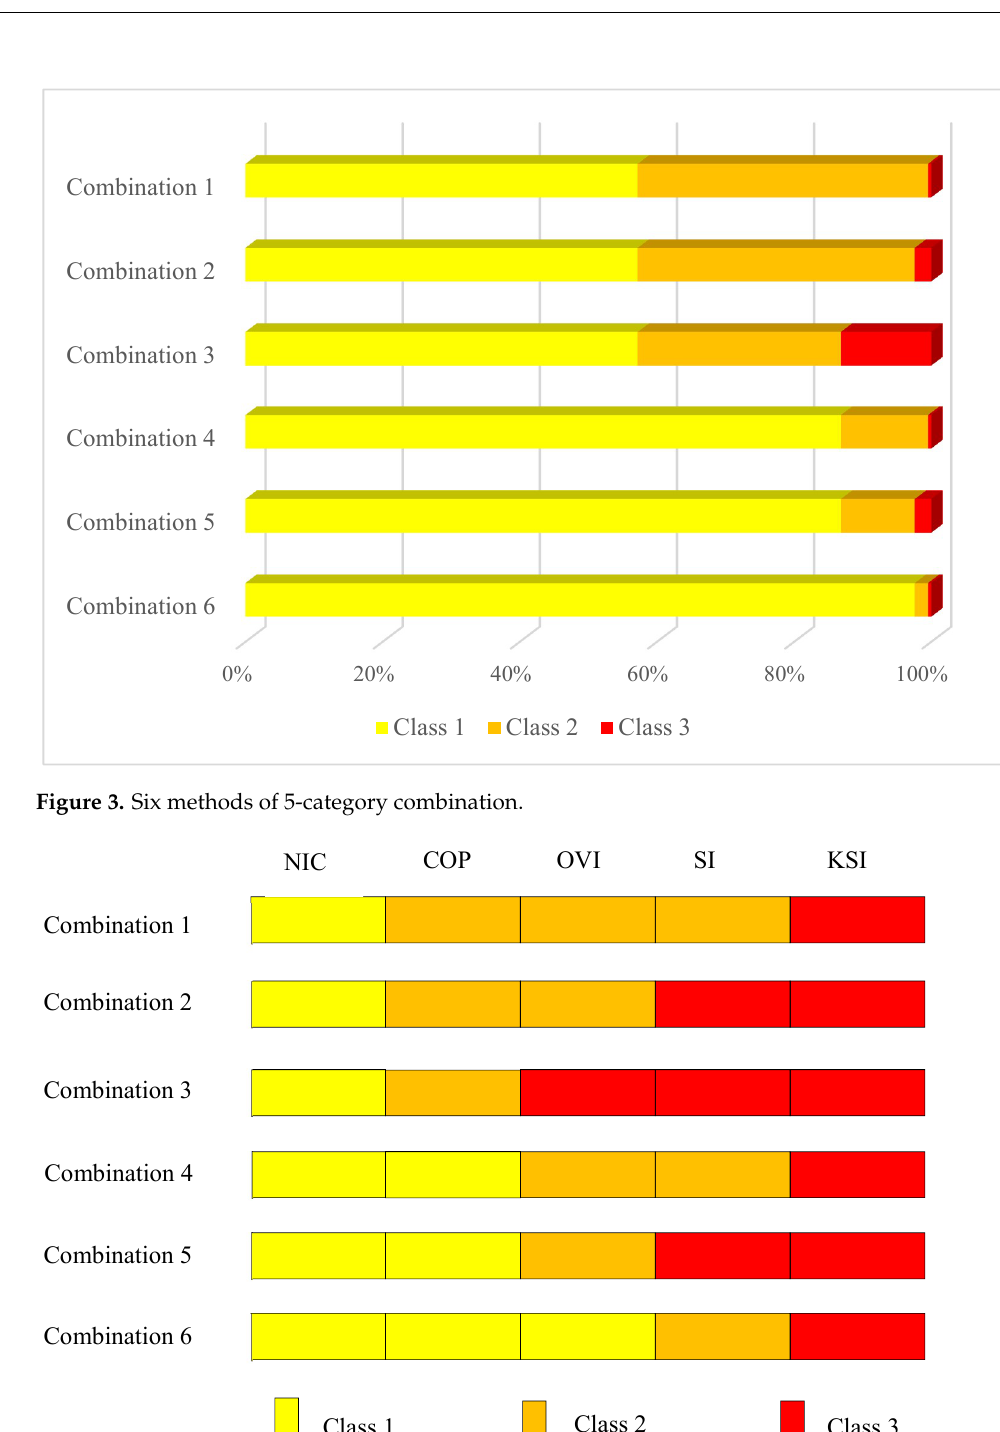
Figure 5. The proportion of classes in each method of category combination after sampling. 3.2. Ordinal Classification 3.2.1. Cumulative Binary Decomposition Given a dataset